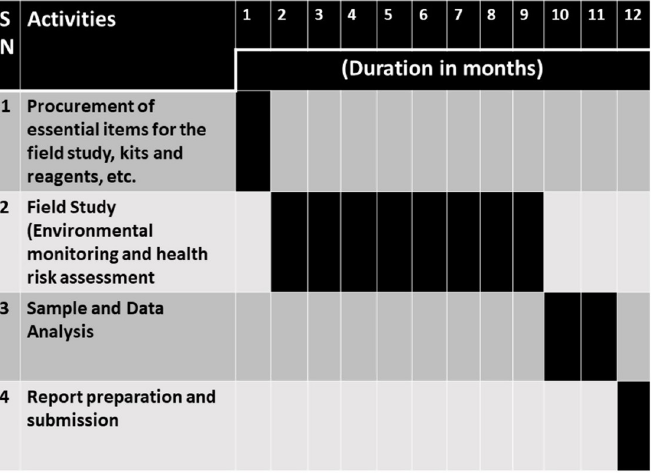
Fig 2. Time schedule of activities. [Note: Each numbered column represents one month of the project duration with the total duration of the project being 12 months].